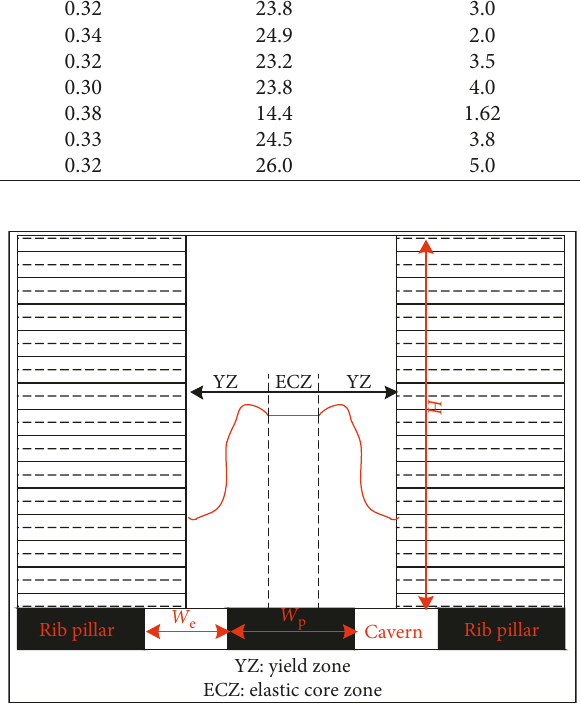
Figure 3: Schematic diagram of the bearing model of rib pillar during highwall